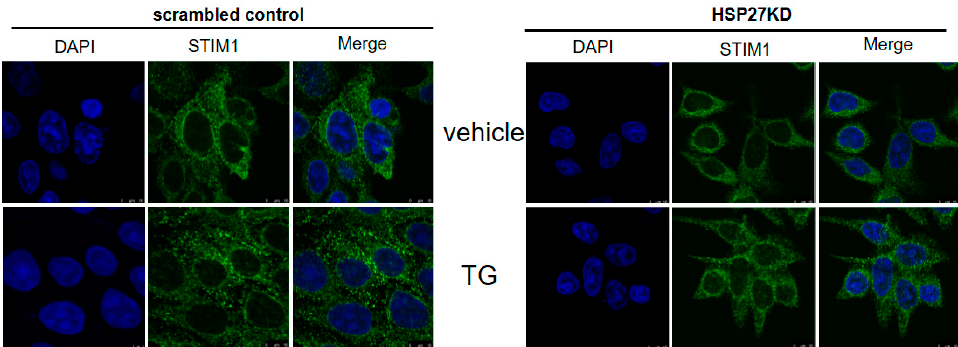
Figure 9. HSP27 promoted STIM1 oligomerization in DLD-1 cells. Scrambled control or HSP27KD DLD cells were seeded into coverslips and then treated with vehicle or TG for 15 min. Cells were fixed, and the distribution of STIM1 was detected by immunocytochemical staining. Confocal microscopy was applied to observe the distribution of STIM1 (green). Nuclei were identified by DAPI. All experiments were independently performed at least 3 times.